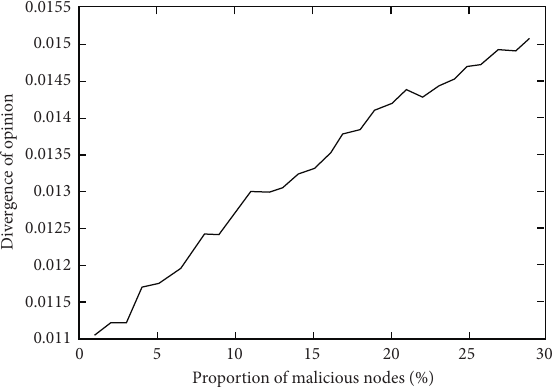
Figure 2: Divergence of group opinion with the proportion of malicious